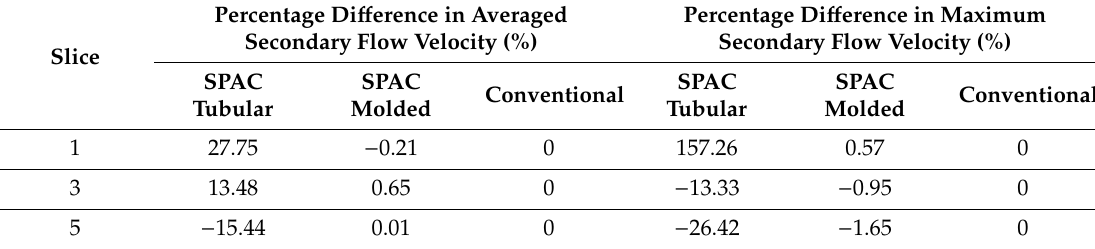
Table 6. The percentage differences of maximum and averaged secondary flow velocity of all designs at t 4.